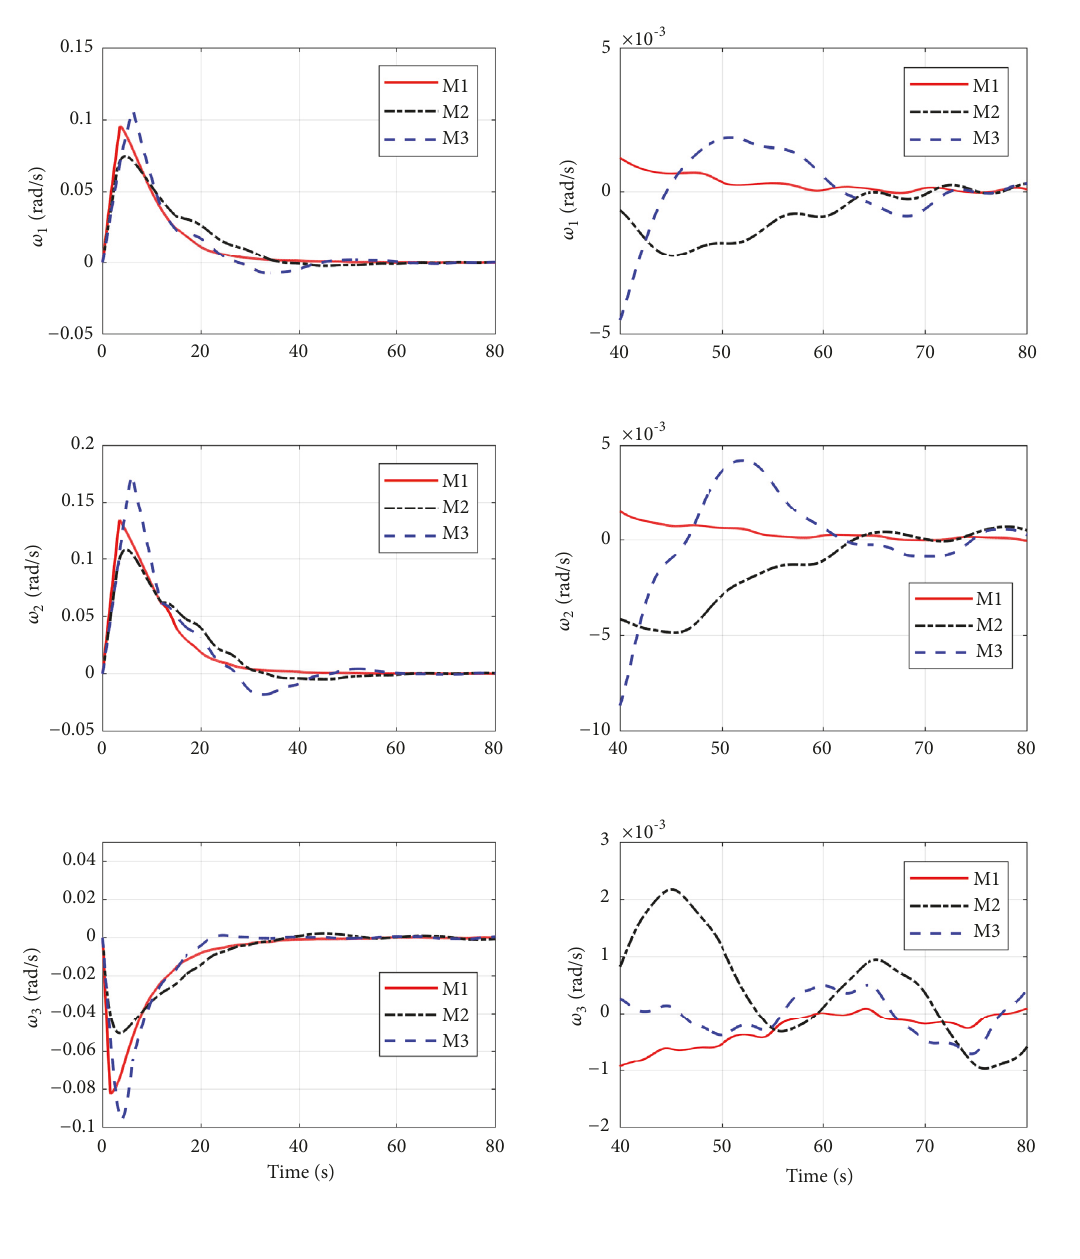
Figure 2: Angular velocity 𝜔